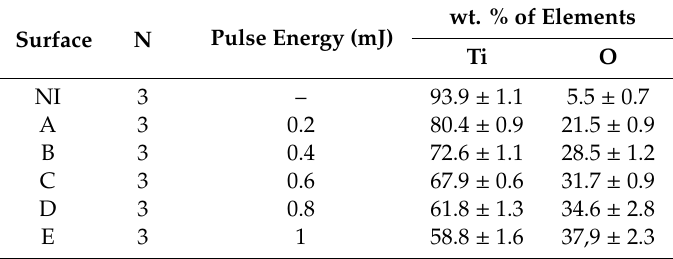
Table 4. The result of the EDS area